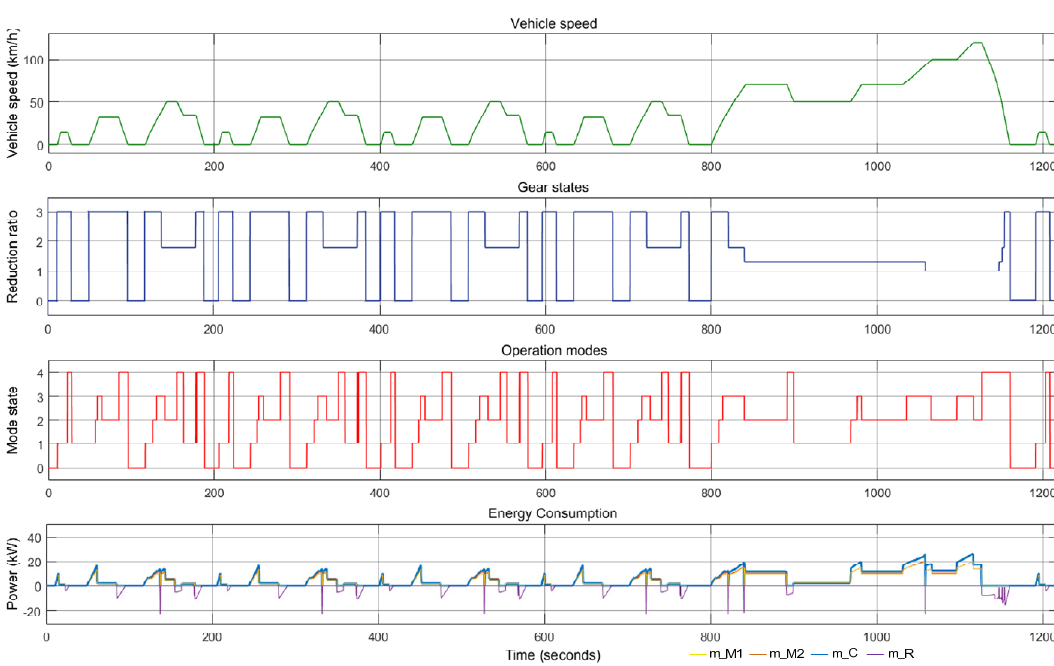
Figure 15. The simulation results of No. 7.